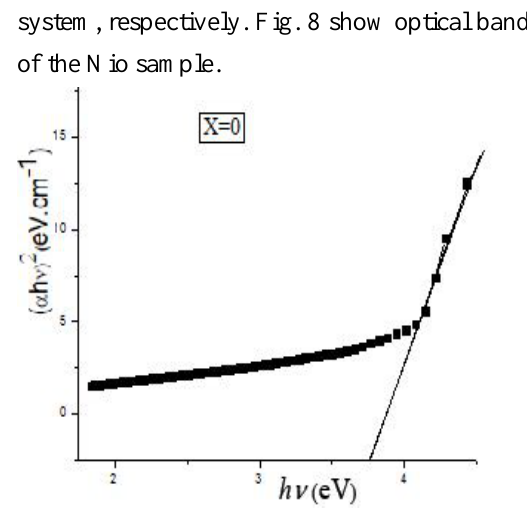
Fig. 8. (αh  ) 2 versus (h  spectra of NiO